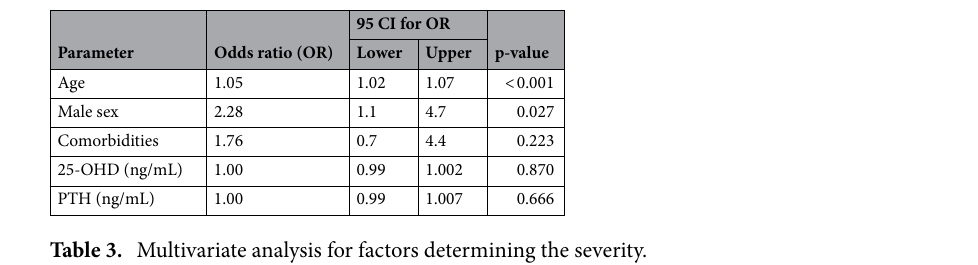
Table 3. Multivariate analysis for factors determining the severity.